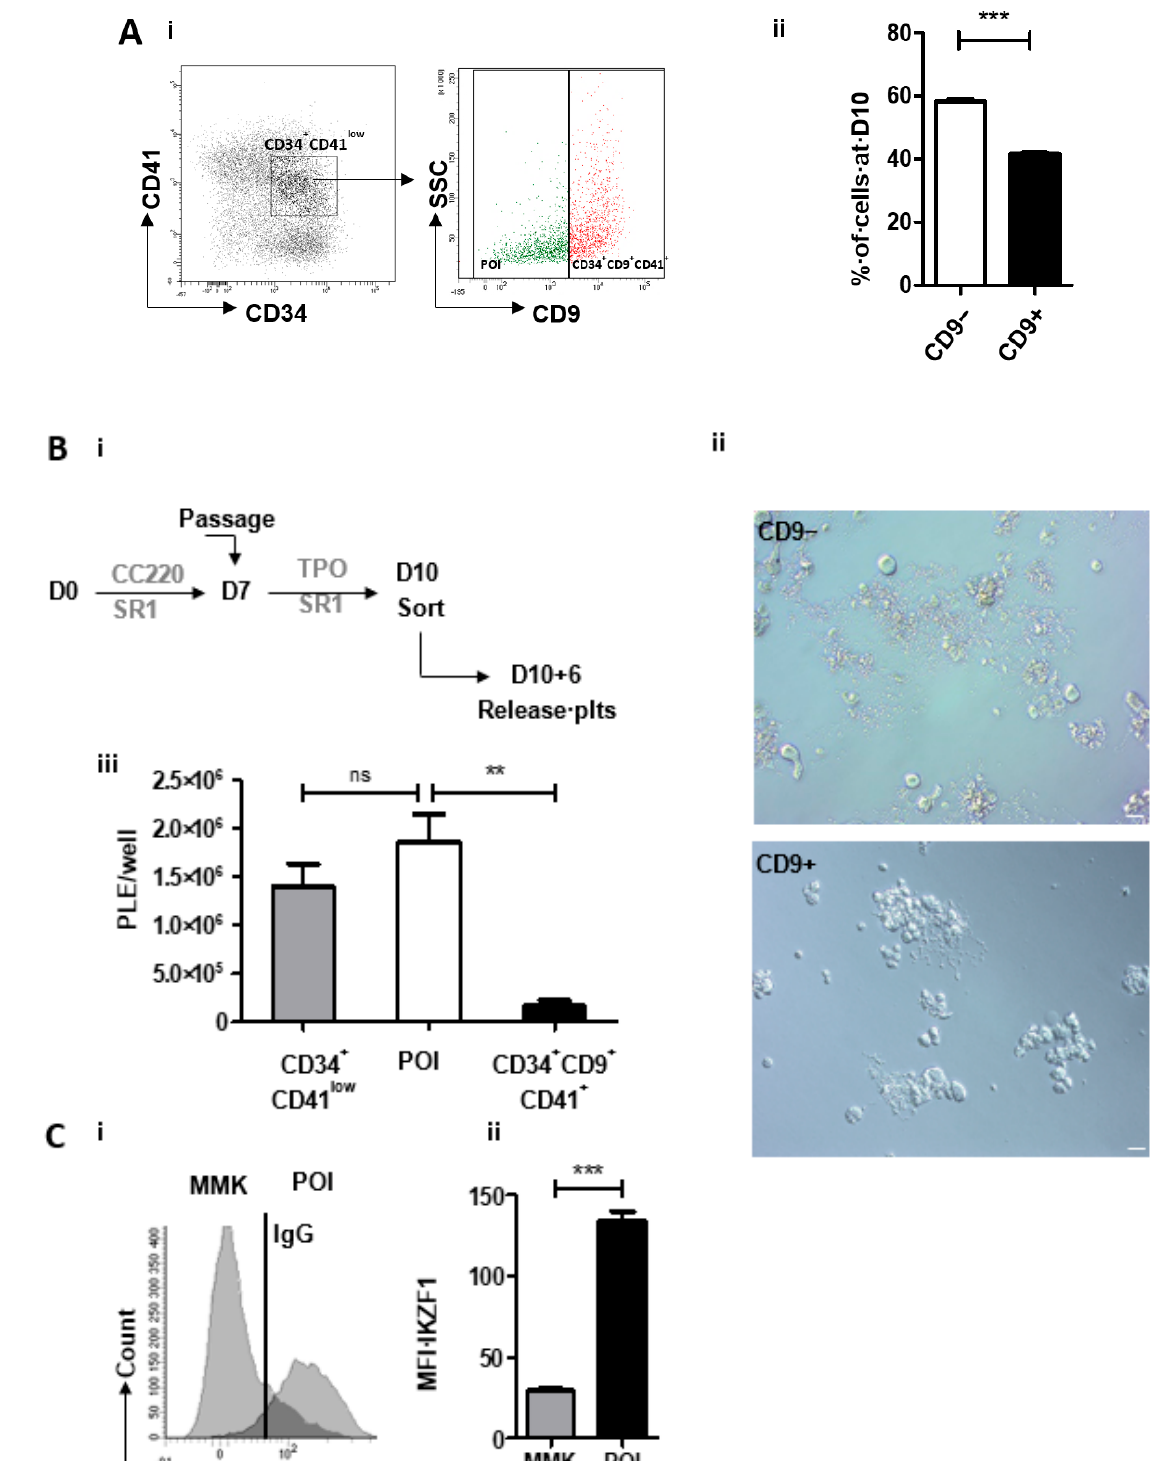
Figure 1. SR1-derived population of interest (POI) expresses IKAROS. ( A ) Refining the CD34 + CD41 low cells phenotype as CD34 + CD41 + CD9 − . i. Expression of CD34 and CD41 markers at day 10 in SR1 culture conditions (left). Flow cytometric analysis of side scatter and CD9 in CD34 + CD41 low cells identifying two subpopulations based on CD9 expression (right). ii. analysis of the percentage of CD9 + and CD9 − subpopulations in CD34 + CD41 low cells (41.4 ± 0.6 CD9 + vs. 58.3 ± 0.7 CD9 − ). (mean ± SEM, n = 5, *** p < 0.001, Student t test). ( B ) Analysis of the capacity of CD34 + CD41 + CD9 − and CD34 + CD41 + CD9 + to produce proplatelets and platelets. i. Culture protocol of CD34 + cells and flow sorting. CD34 + cells cultured for 10 days in the